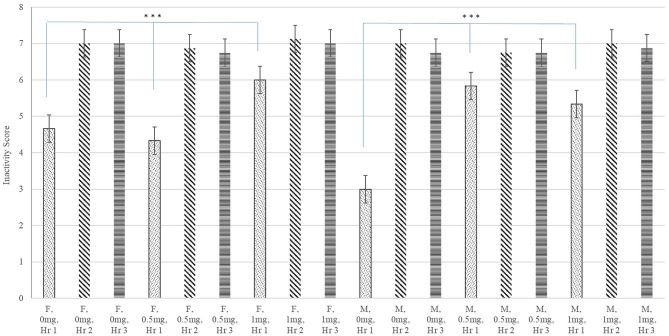
Inactivity score (estimate and standard error of the mean) by Poly(I:C) dose (0, 0.5, or 1 mg/kg of body weight), sex (F = female or M = male), and hour (Hr 1, 2, or 3) after injection. ***Differences between Poly(I:C) doses within sex in hour 1 significant at P-value < 0.005 (n = 10). Scores are unitless and values range from 1 (highly active) to 8 (inactive).